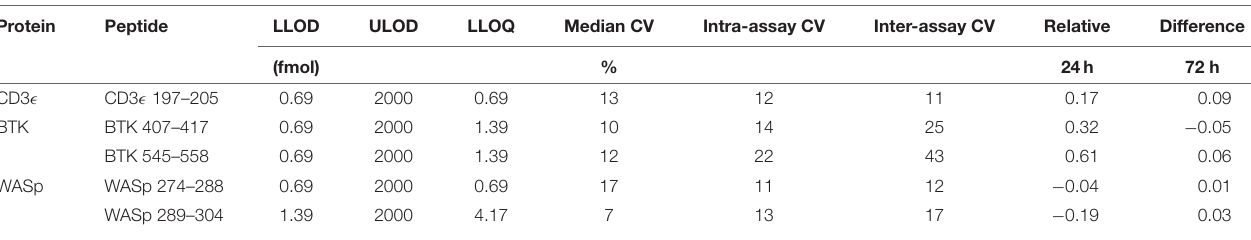
TABLE 3 | Analytical performance of signature peptides. Protein